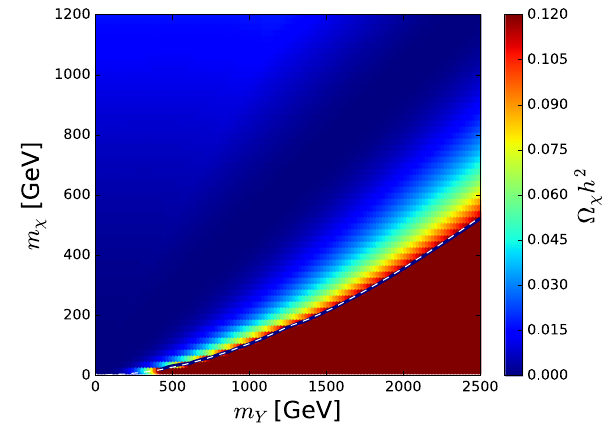
Fig. 1 Comparison of our calculation of (cid:4) χ h 2 (colours and solid blue line) with the (cid:4) χ h 2 = 0 . 12 curve shown by the CMS Collaboration in [75] (dashed white line) for the DMSM with a spin-one mediator = 0 . 25, g V = 1 to quarks and to having vector-like couplings g V SM DM DM particles χ ,